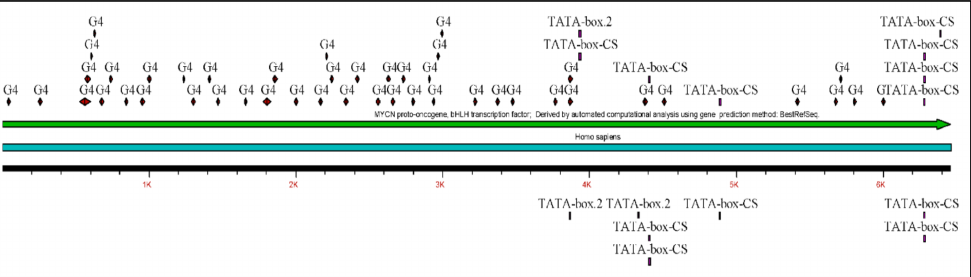
Figure 6. The reconstructed MYCN map based on the previous predictions from Figure 5 (legend: G4: G-Quadraplex position).